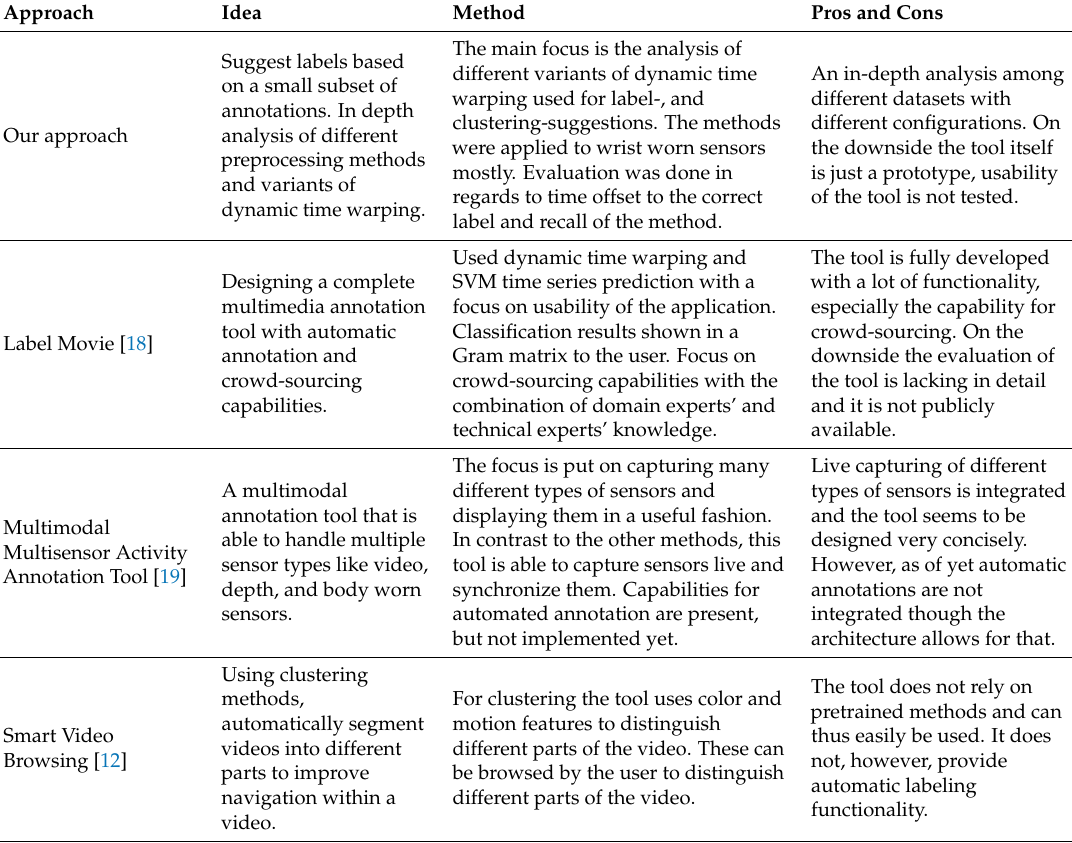
Table 1. Comparison of different annotation tools with their different